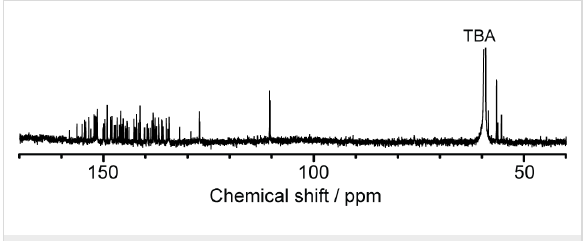
Figure 14: 13 C NMR spectrum of [ 5b ] − in acetone- d 6 /CS 2 (3/1 = v/v).